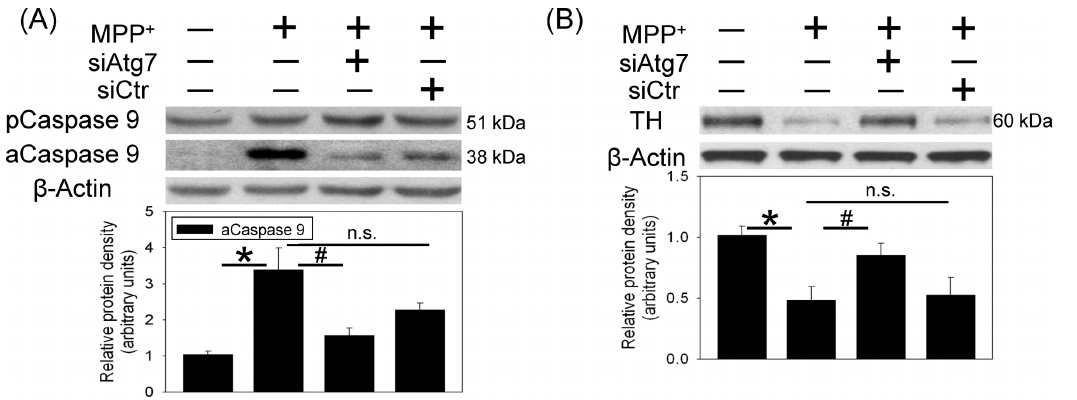
Figure 3. Invivo Atg7siRNA transfection attenuated MPP + -induced caspase 9 activation and tyrosine hydroxylase (TH) reduction in the nigrostriatal dopaminergic system of rat brain. Intranigral infusion of Atg7siRNA was performed 4 d prior to intranigral infusion of MPP + (3 m g/ m l) in the anesthetized rats. Rats were sacrificed 30 h after intranigral infusion of MPP + . (A) Caspase 9 in the substantia nigra (SN) was measured using Western blot assay. Each lane contained 25 m g protein for the experiments. Values are the mean 6 S.E.M. (n=4/group). * P , 0.05 in the MPP + - infused SN compared with the intact SN, # P , 0.05 in Atg7siRNA transfected and MPP + -infused SN compared with MPP + -infused SN, n.s. for not significant by Kruskal-Wallis test and followed by Mann-Whitney U test as post-hoc method. (B) TH in the substantia nigra (SN) was measured using Western blot assay. Each lane contained 3 m g protein for the experiments. Graphs show statistical results from relative optical density of bands on the blots estimated by Image J software. Values are the mean 6 S.E.M. (n=3/group). *P , 0.05 in the MPP + -treated groups compared with the control groups by one-way analysis of variance (one-way ANOVA) and followed by the LSD test as post-hoc method.